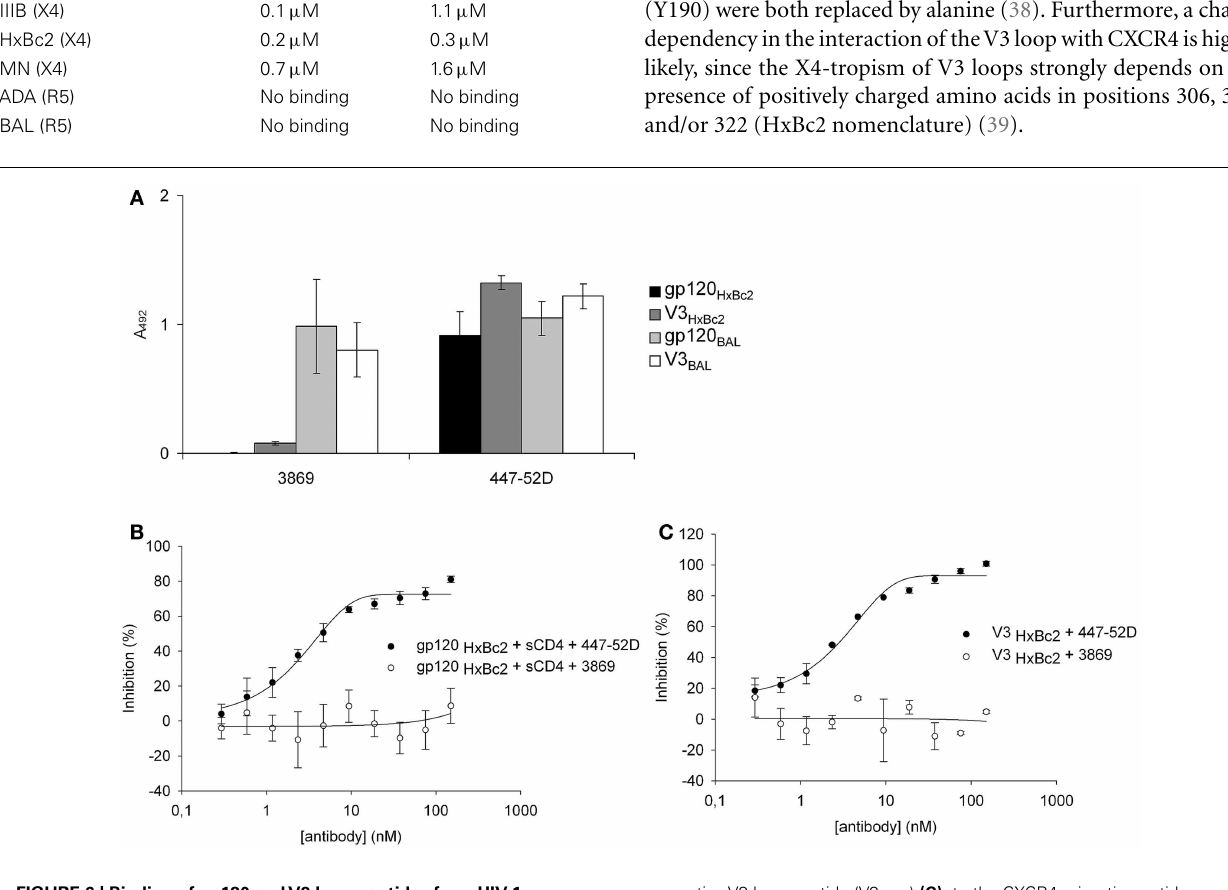
respectiveV3 loop peptide (V3 HxBc2 ) (C) , to the CXCR4 mimetic peptide CX4-M1. See Section “Materials and Methods” (anti-V3 mAb ELISA and Competitive ELISA) for experimental detail. Error bars present deviations from the